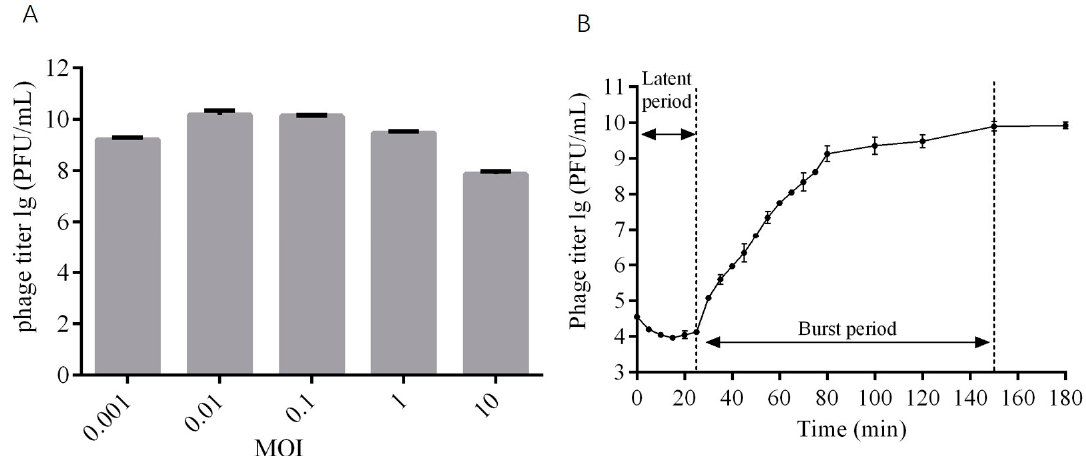
Figure 2. The optimal MOI and one-step growth curve of phage DCp1. ( A ) The titers of phage DCp1 at different MOIs (0.001, 0.01, 0.1, 1, and 10). ( B ) The one-step growth curve of phage DCp1. Phage DCp1 was mixed with C. perfringens D22 at the MOI of 10. The titer of phage DCp1 was determined at different time points within 3 h.